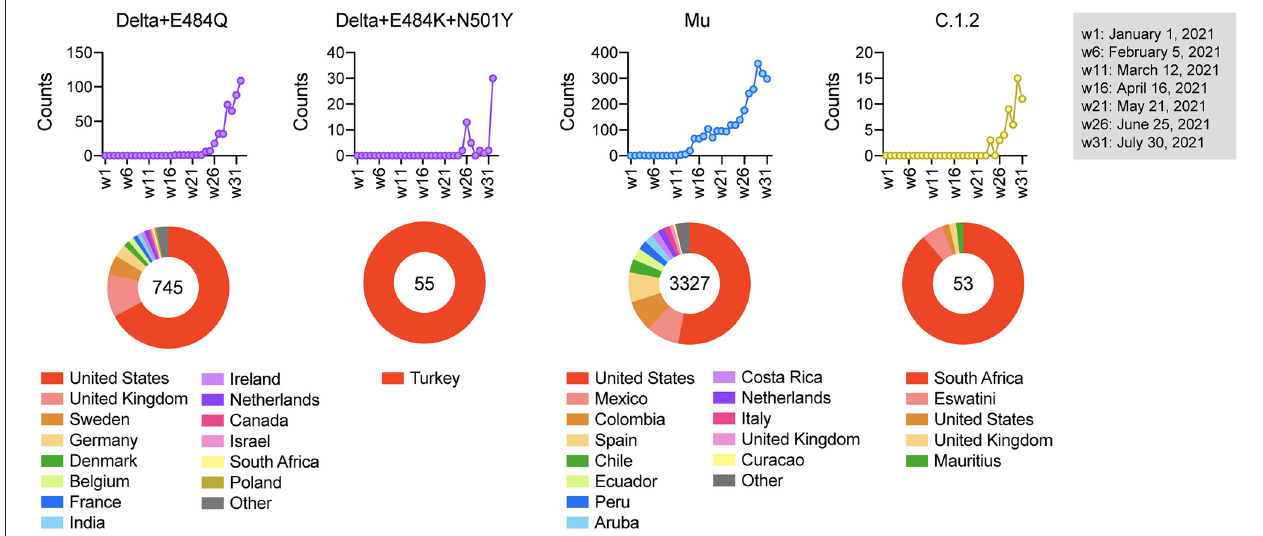
FIGURE 4 | Epidemiological characterization of vaccine-escape variants. The upper graph shows the number of variants detected from week 1 to week 32 in 2021, and the lower pie chart shows the countries where the variants were detected. The numbers in the pie chart represent the number of detections.